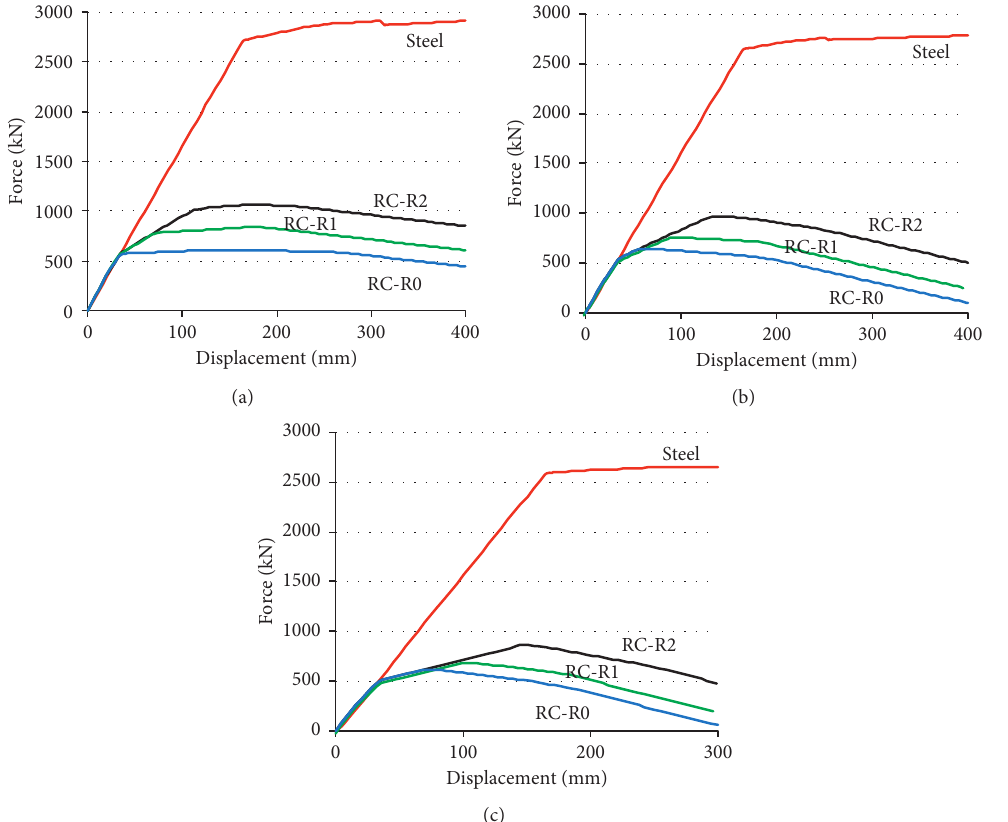
� 0, (b) R � 0.2, and ac . (a) R ac ac